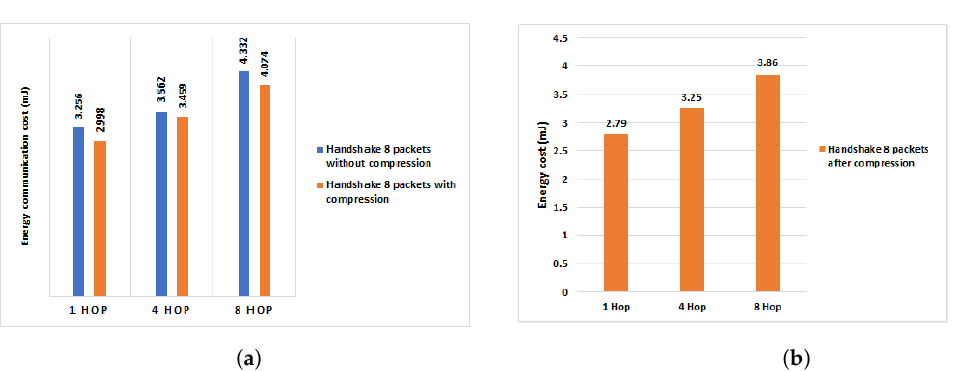
Figure 13. Energy communication costs of HIP DEX handshake packets + signalling packets before optimization (8 packets). ( a ): Calculation done according to results obtained in [9].( b ): Results obtained with